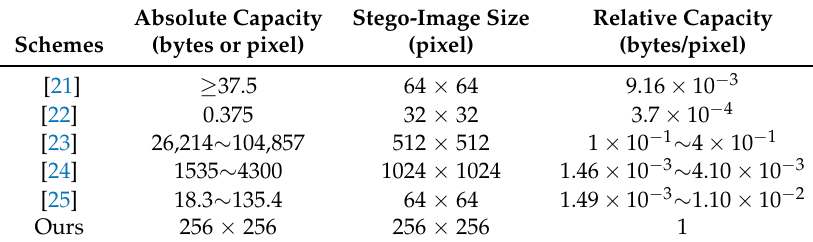
Table 5. Steganographic capacity comparison.